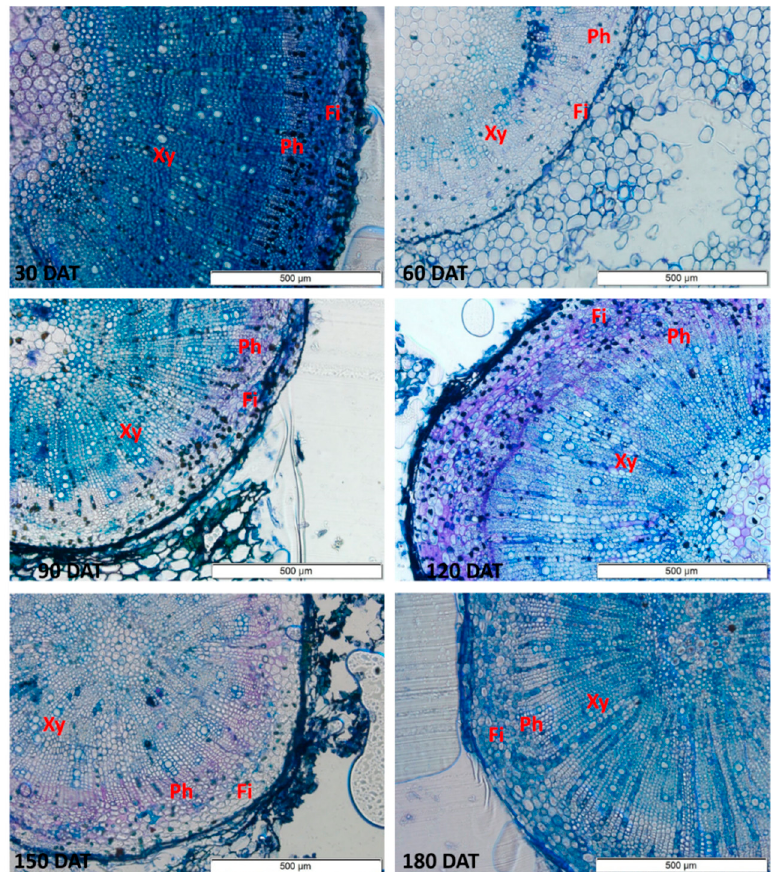
Figure 5. Sections of the root of the seedlings of Hymenaea courbaril L. cultivated in a hydroponic system, showing the different anatomical features (Xy = Xylem; Ph = Phloem; Fi = Fibers). Sections obtained at 30-day intervals across the initial development of the plants (30, 60, 90, 120, 150, and 180 days after transplantation).